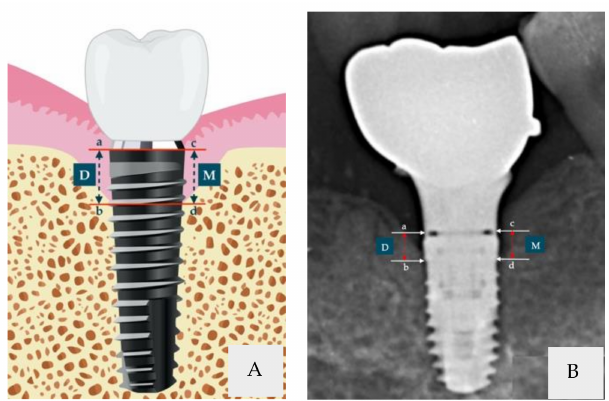
Figure 1. Schematic illustration of submerged dental implants. ( A ) Vector illustration, ( B ) X-ray image. The marginal bone level was measured from the rough–smooth border of the implant surface to the alveolar crest on the mesial and distal aspects of the tooth. D, length of the distal surface (a–b); M, length of the mesial surface